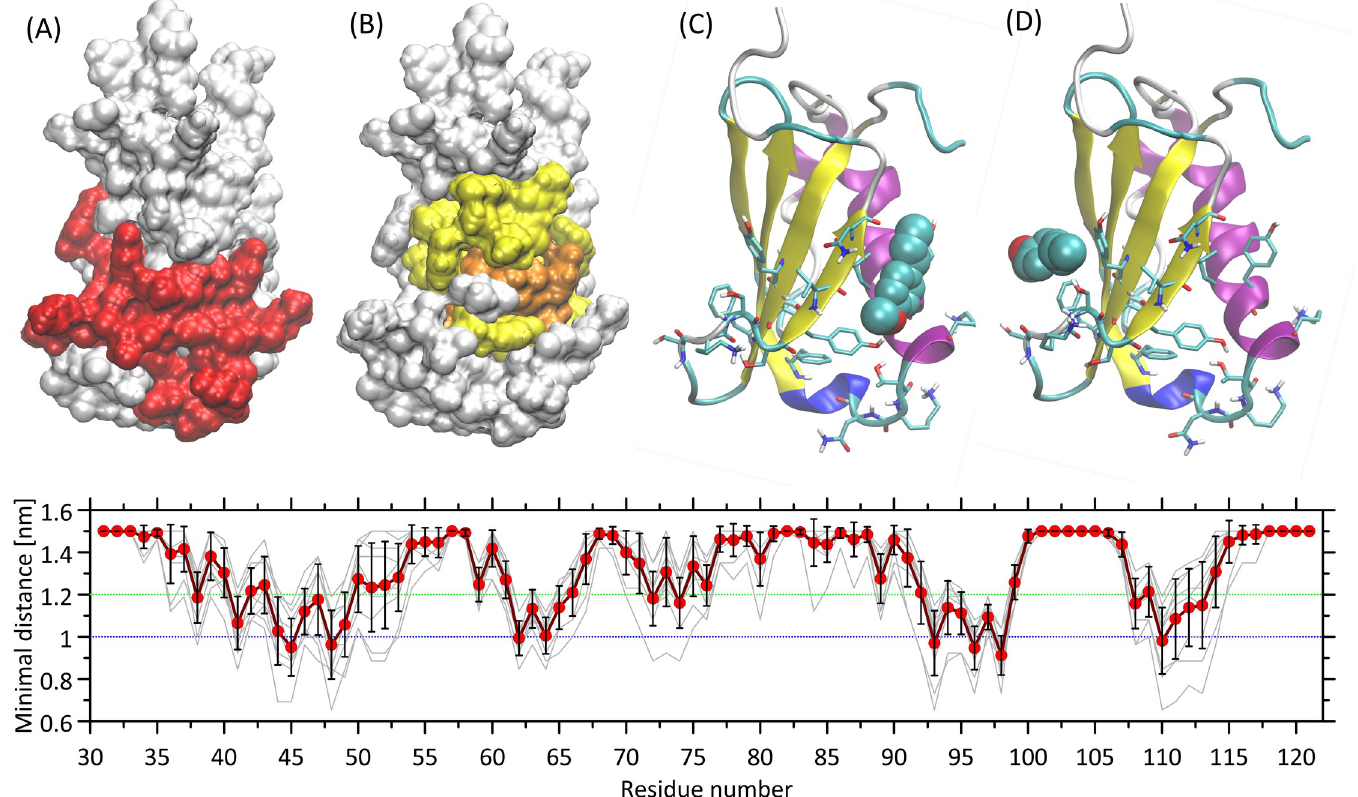
Fig 3. The graphical illustration of molecular modeling results. (A) The surface representation of the CHIPS protein (PDB:2KU3) with amino-acid residues maintaining contact with the C5a receptor N-terminus marked in red. The contact is defined as the minimal distance between any atom pair smaller than 0.25 nm. (B) The MD simulation results depicted as the amino-acid residues that are most prone to exhibit contact with the TA molecules during unbiased MD simulations; the residues displaying average, minimal distance below 1.2 nm and 1 nm are shown in yellow and orange, respectively. (C, D) The two most favorable locations of TA interacting with CHIPS that were found during docking procedure. The rotatable sidechains of amino-acid residues belonging to the C5a/CHIPS interface are marked as sticks, whereas the TA molecule is represented as van der Waals spheres. ( bottom panel ) Quantitative results showing the average, minimal distance between TA molecules and all amino-acid residues of CHIPS. The thin gray lines represent individual contributions from each of the 10 TA molecules present in the system, whereas the thick, red line shows the average value. The vertical bars represent the standard deviations. The dotted green and blue lines correspond to cutoffs defining the residues shown in the panel